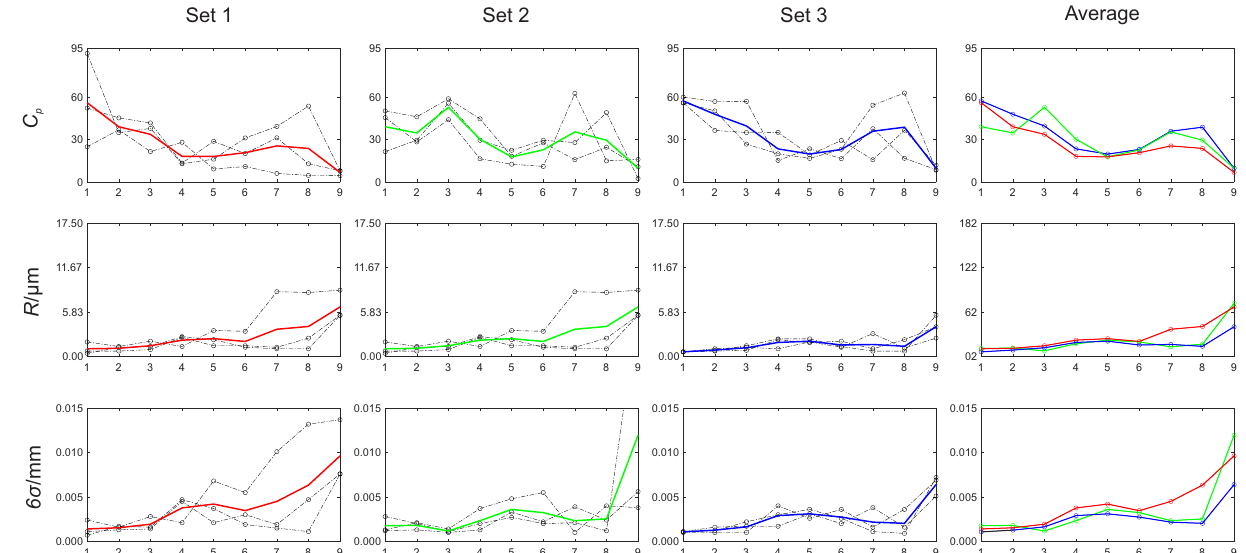
Figure 9. Measurement results for a Magnet characteristic code 30 (height) for all the measuring sets and the average. The red line represents the average of set 1, the green line represents the average of set 2, the blue line represents the average of set 3, and the black dotted lines represent individual repetitions of the desired set of measurements. The absolute value of statistical parameters ( C p , R , and 6 σ ) is not as significant as the decreasing/increasing trend. Scenario numbers appear on the horizontal axis.